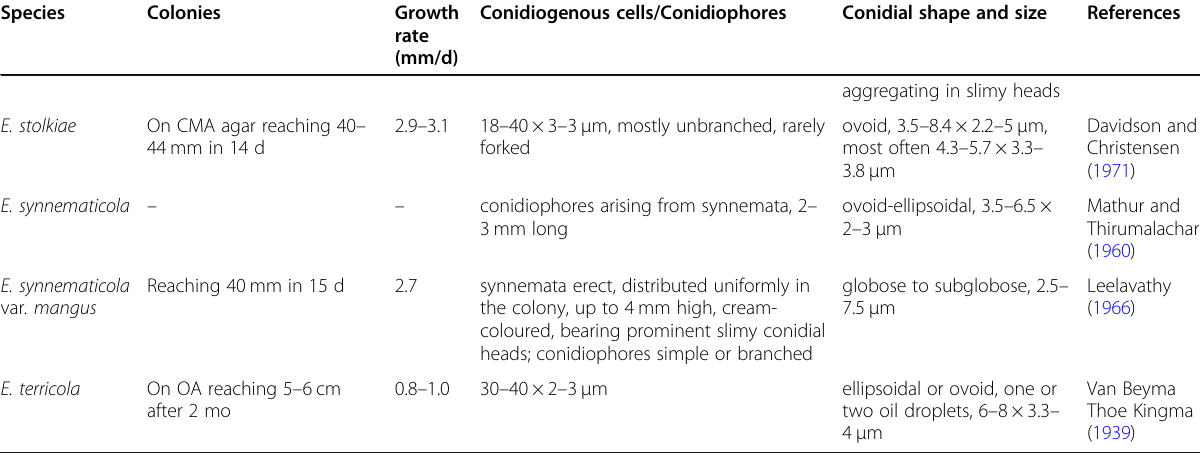
Table 2 Morphological comparison of Emericellopsis spp. (Continued)